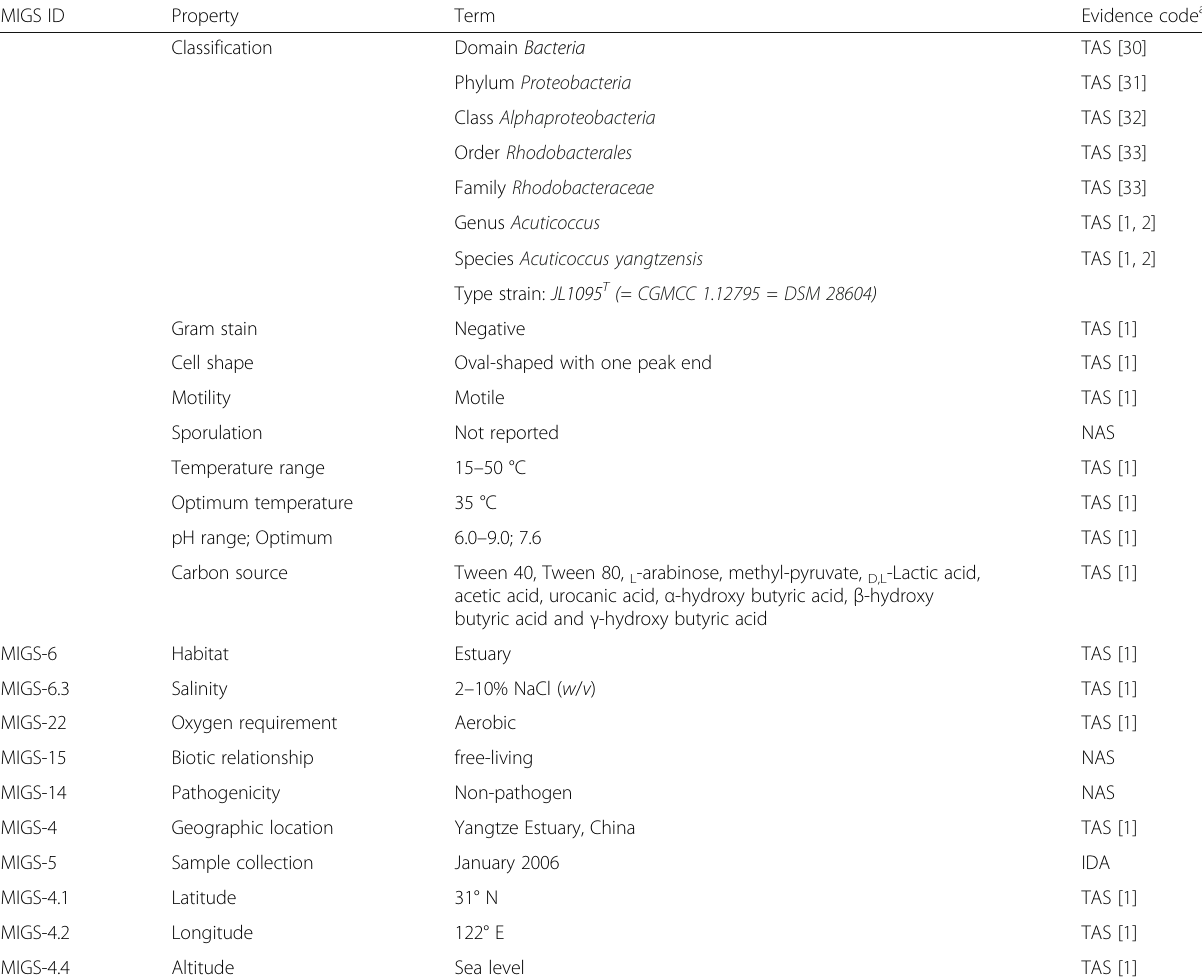
Table 1 Classification and general features of Acuticoccus yangtzensis strain JL1095 T [16] MIGS